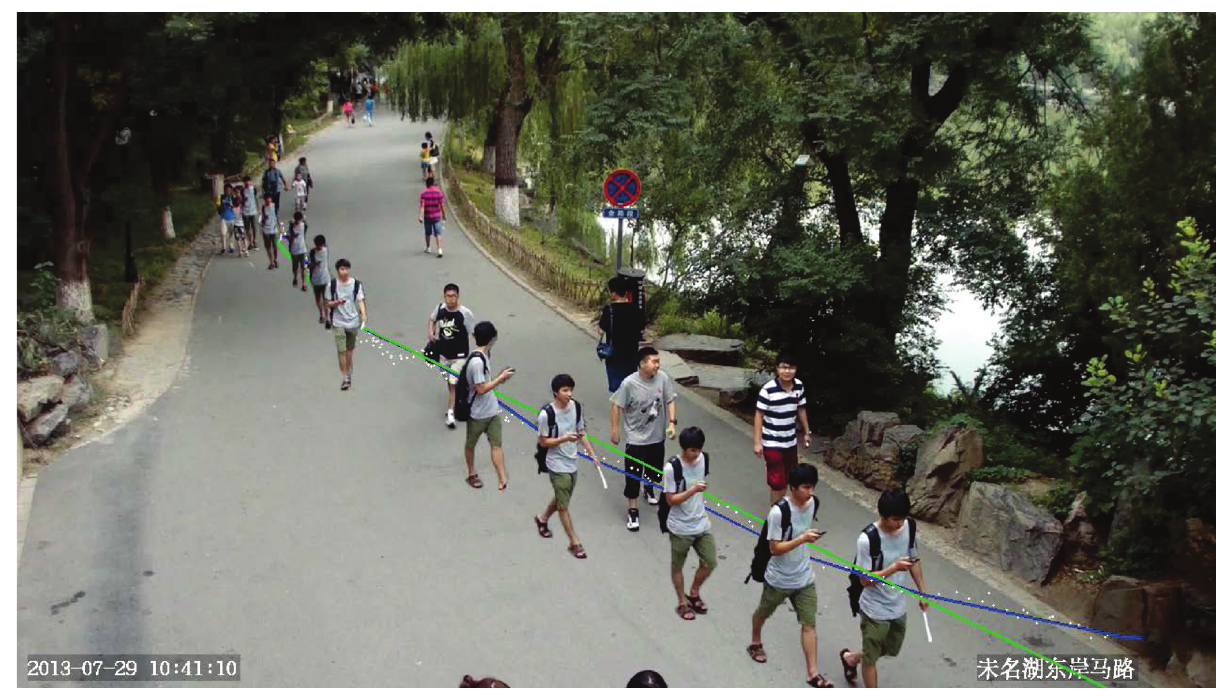
Fig 5. Illustration of the WTF algorithm by using the man wearing a grey T-shirt: The blue line represents his walking trajectory in several gait cycles, while the green one denotes the fitted walking line in the gait period. For better visualization, all his silhouette images in a gait period are manually superposed in one picture.